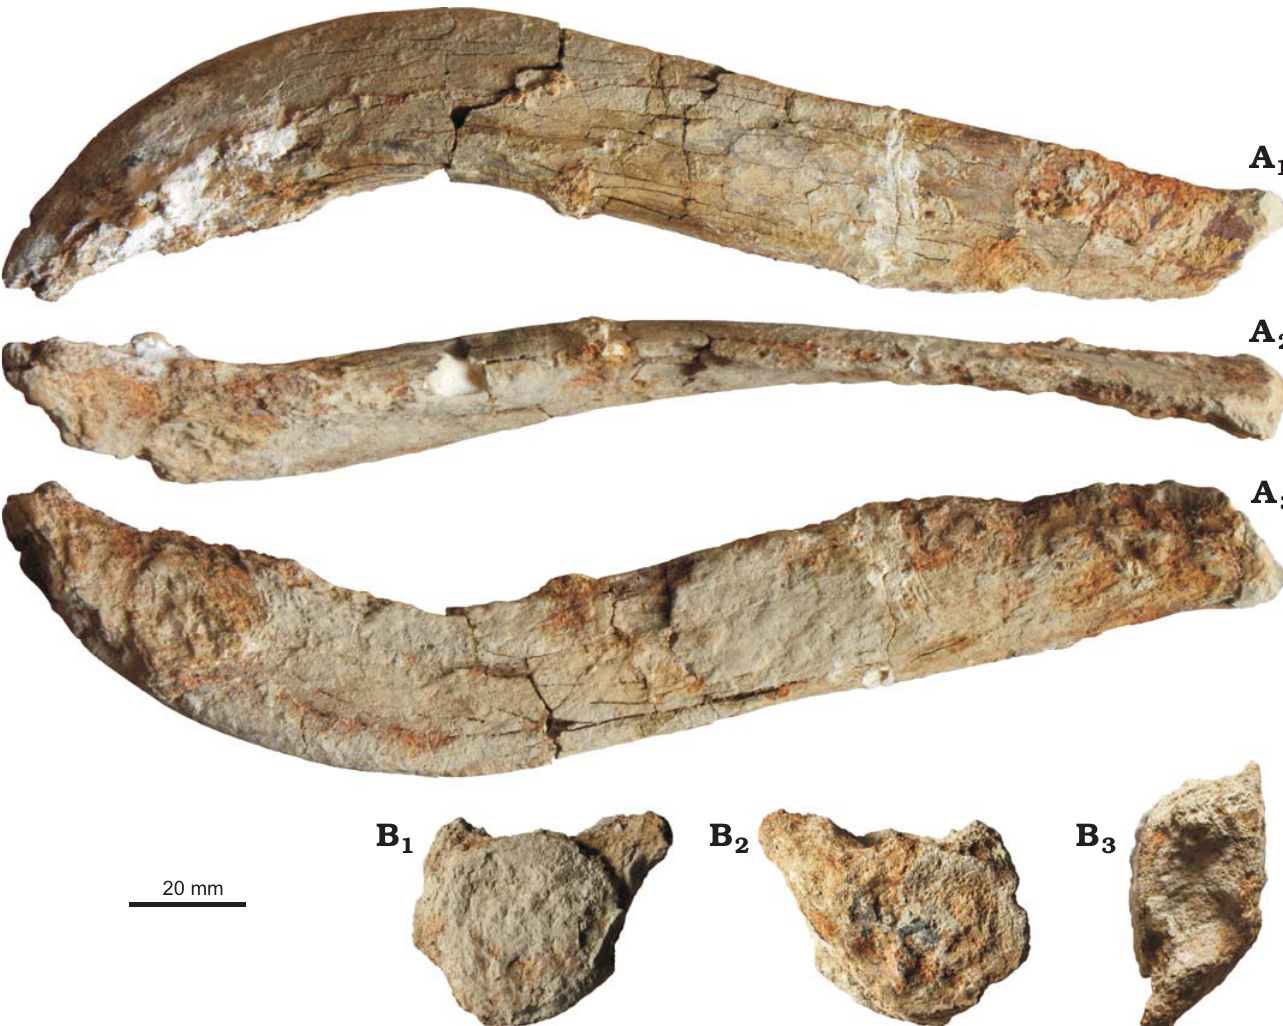
Fig. 8. Postcranial bones of the kogiid sperm whale Pliokogia apenninica gen. et sp. nov. (MSNUP I-17603, holotype), from the lower Pliocene of Sant’Andrea Bagni (Northern Apennines, northern Italy). A . Fragmentary right rib in dorsal (A 1 ), posterior (A 2 ), and ventral (A 3 ) views. B . Fragmentary thoracic vertebra in anterior (B 1 ), posterior (B 2 ), and dorsal (B 3 ) views.